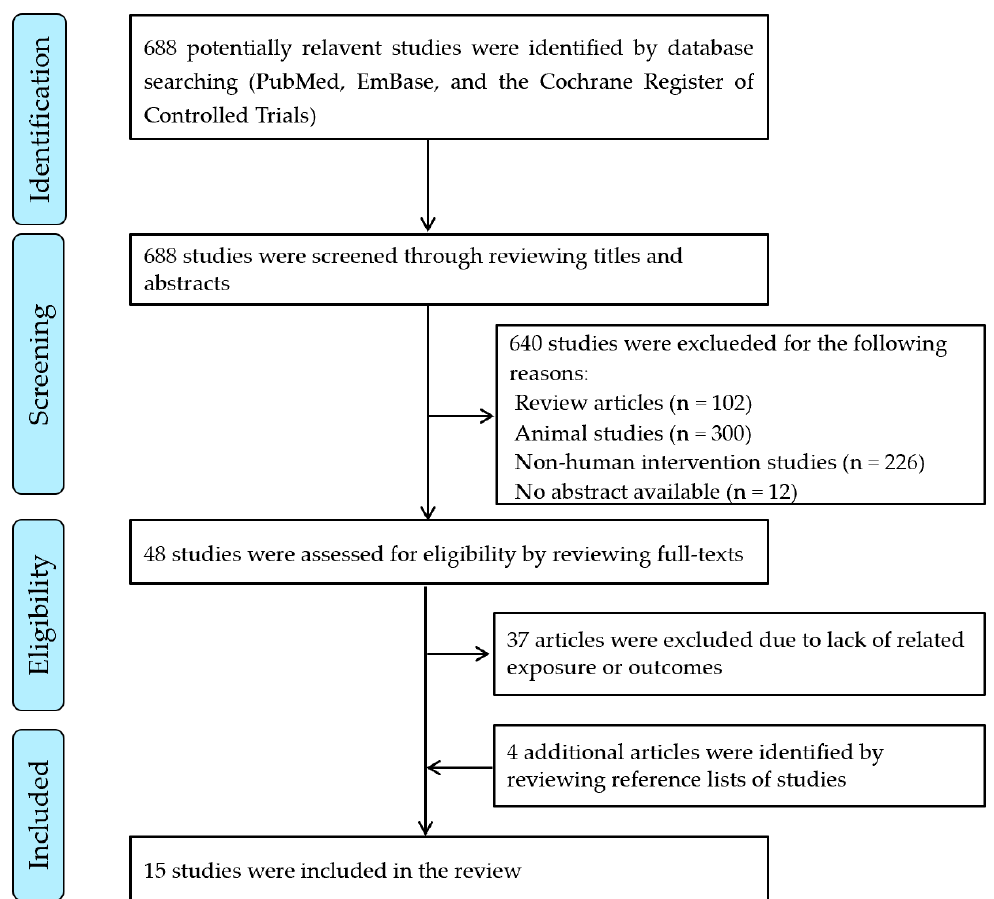
Figure 1. Flow diagram of identification, screening, and selection process for included articles.